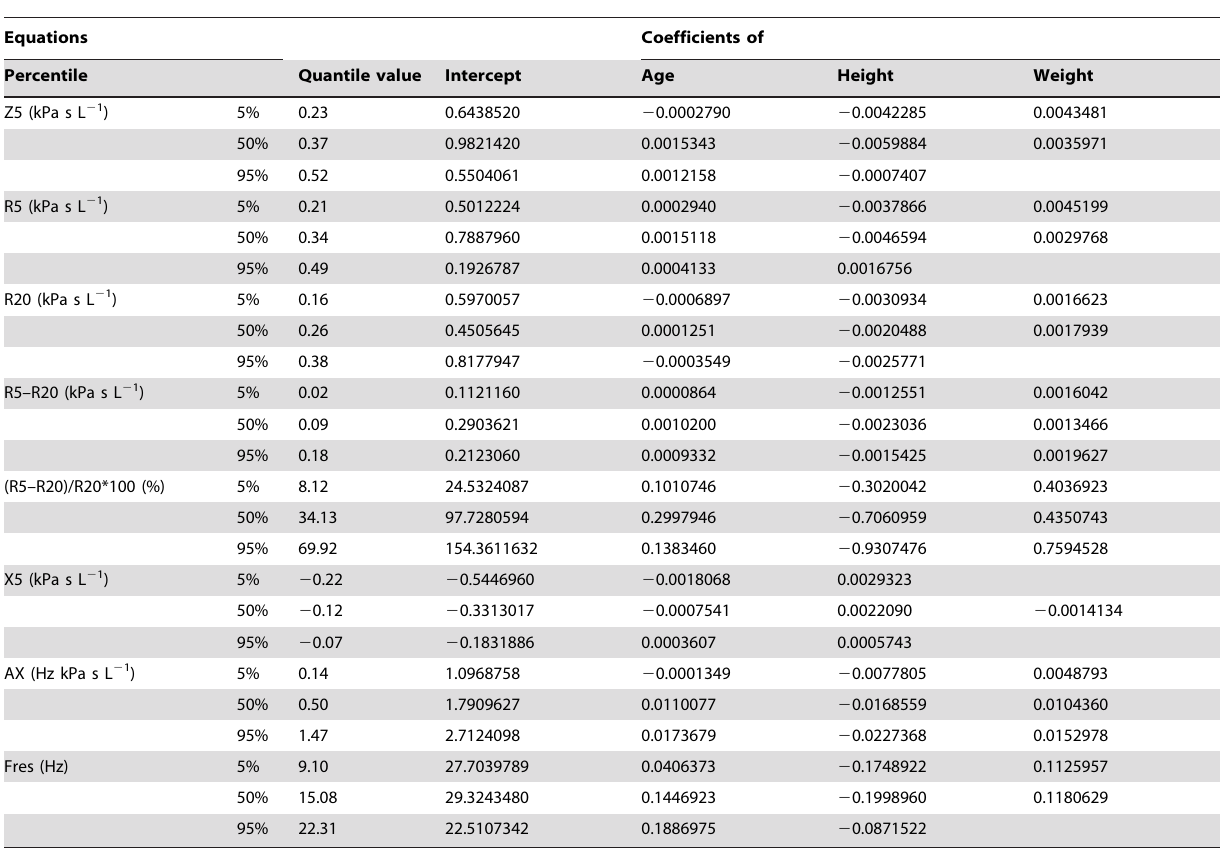
Table 4. Reference equations of commonly applied IOS indices for women.